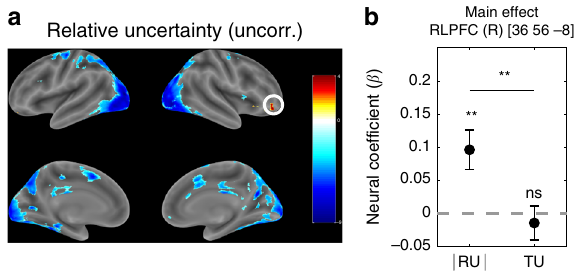
Fig. 3 Right RLPFC tracks relative but not total uncertainty. a Whole- brain ∣ RU t ∣ contrast from GLM 1. Single voxels were thresholded at p < 0.001. Multiple comparisons correction was not applied (corrected version is shown in Supplementary Fig. 7A). The color scale represents t -values across subjects. The circled ROI in right RLPFC (MNI [36 56 − 8]) from Badre et al. 26 was used in the subsequent con fi rmatory analysis (10-mm sphere around the peak voxel). b Neural regression coef fi cients (betas) from GLM 1 for the parametric modulators ∣ RU t ∣ ( β ∣ RU ∣ ) and TU t ( β TU ) at trial onset, averaged across voxels in the ROI. Error bars are cross-subject standard errors. Comparisons were made using Student ’ s t -tests. ** p < 0.01, ns: not signi fi cant. Source data are provided as a Source Data fi